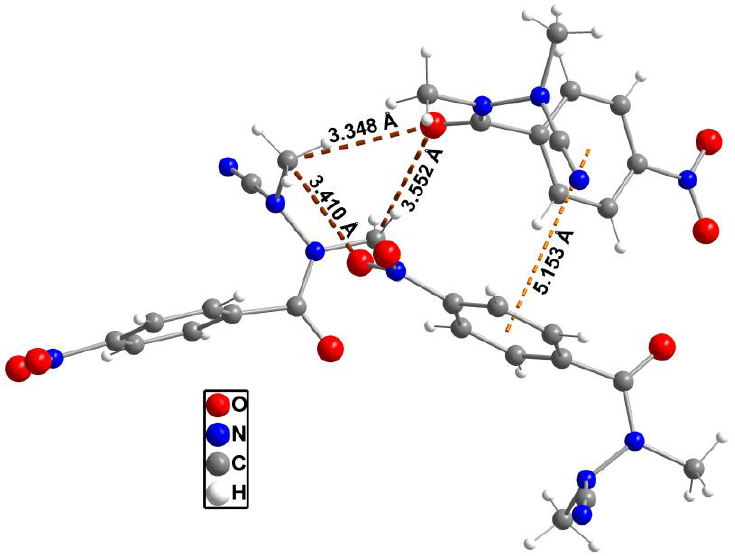
Figure 3. Network of intermolecular contacts in the crystal as represented by three neighboring molecules.